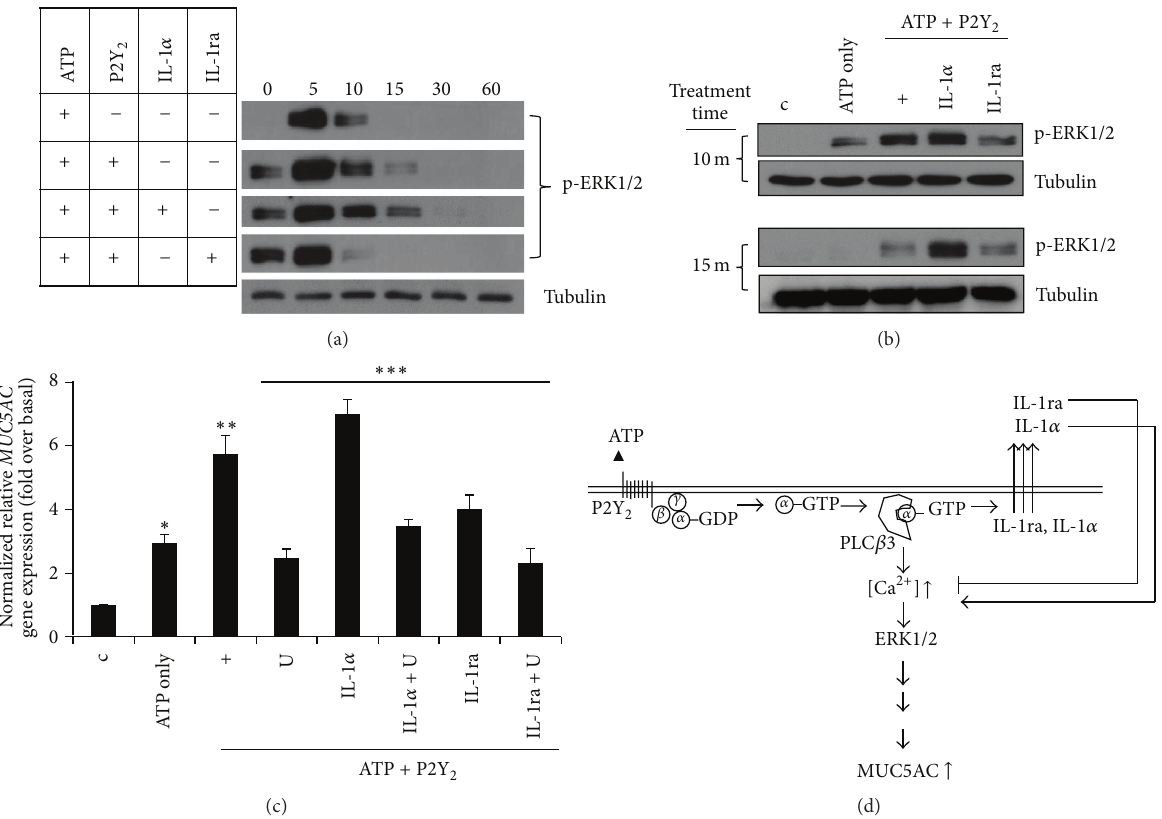
Figure 4: IL-1ra decreases ATP/P2Y 2 -induced MUC5AC gene expression by inhibiting ERK1/2 activation. After transfection with wild-type P2Y 2 , the cells were treated with either IL-1ra or IL-1 𝛼 for 4 hours prior to treatment with ATP for different times (a) or either 10 or 15 min (b). ERK1/2 phosphorylation was analyzed by Western blot. Tubulin was used as a loading control. (c) After transfection with wild-type P2Y 2 , the cells were treated with IL-1ra, IL-1 𝛼 , or U0126 (10 𝜇 M) for 4 hours prior to treatment with ATP for 24 hours. qRT-PCR for MUC5AC transcript was performed. ∗ 𝑝 < 0.05 compared to the control, ∗∗ 𝑝 < 0.05 compared to ATP only, and ∗∗∗ 𝑝 < 0.05 compared to ATP/P2Y 2 -treated cells. Data shown are representative of three independent experiments. (d) A schematic diagram is presented to show the potential mechanisms for secretion of IL-1ra and IL-1 𝛼 , and their physiological roles during inflammatory